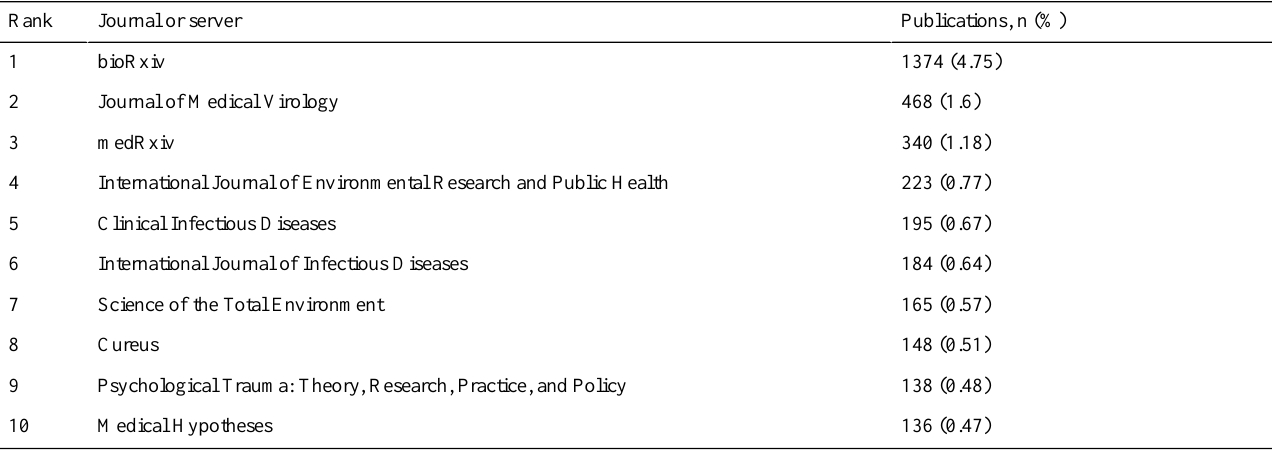
Table 2. Top 10 sites (journals and preprint servers) where COVID-19–related articles (N=28,904) were published.